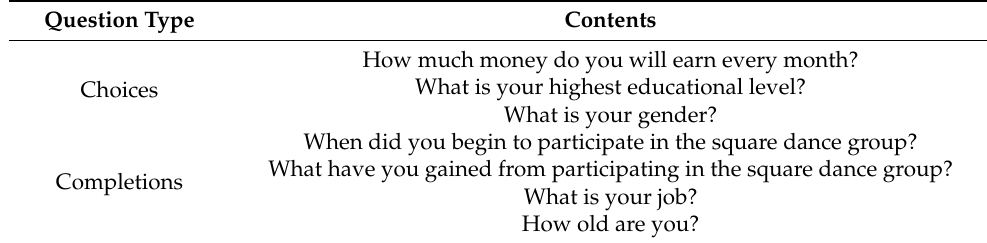
Table 1. Self-edited list of